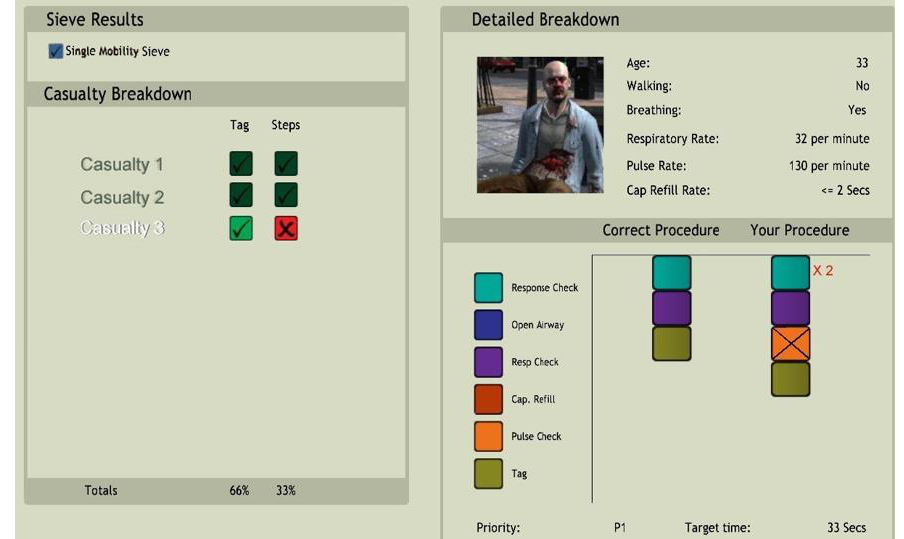
Figure 2. The more immediate and simpler feedback in the final version of the triage game.